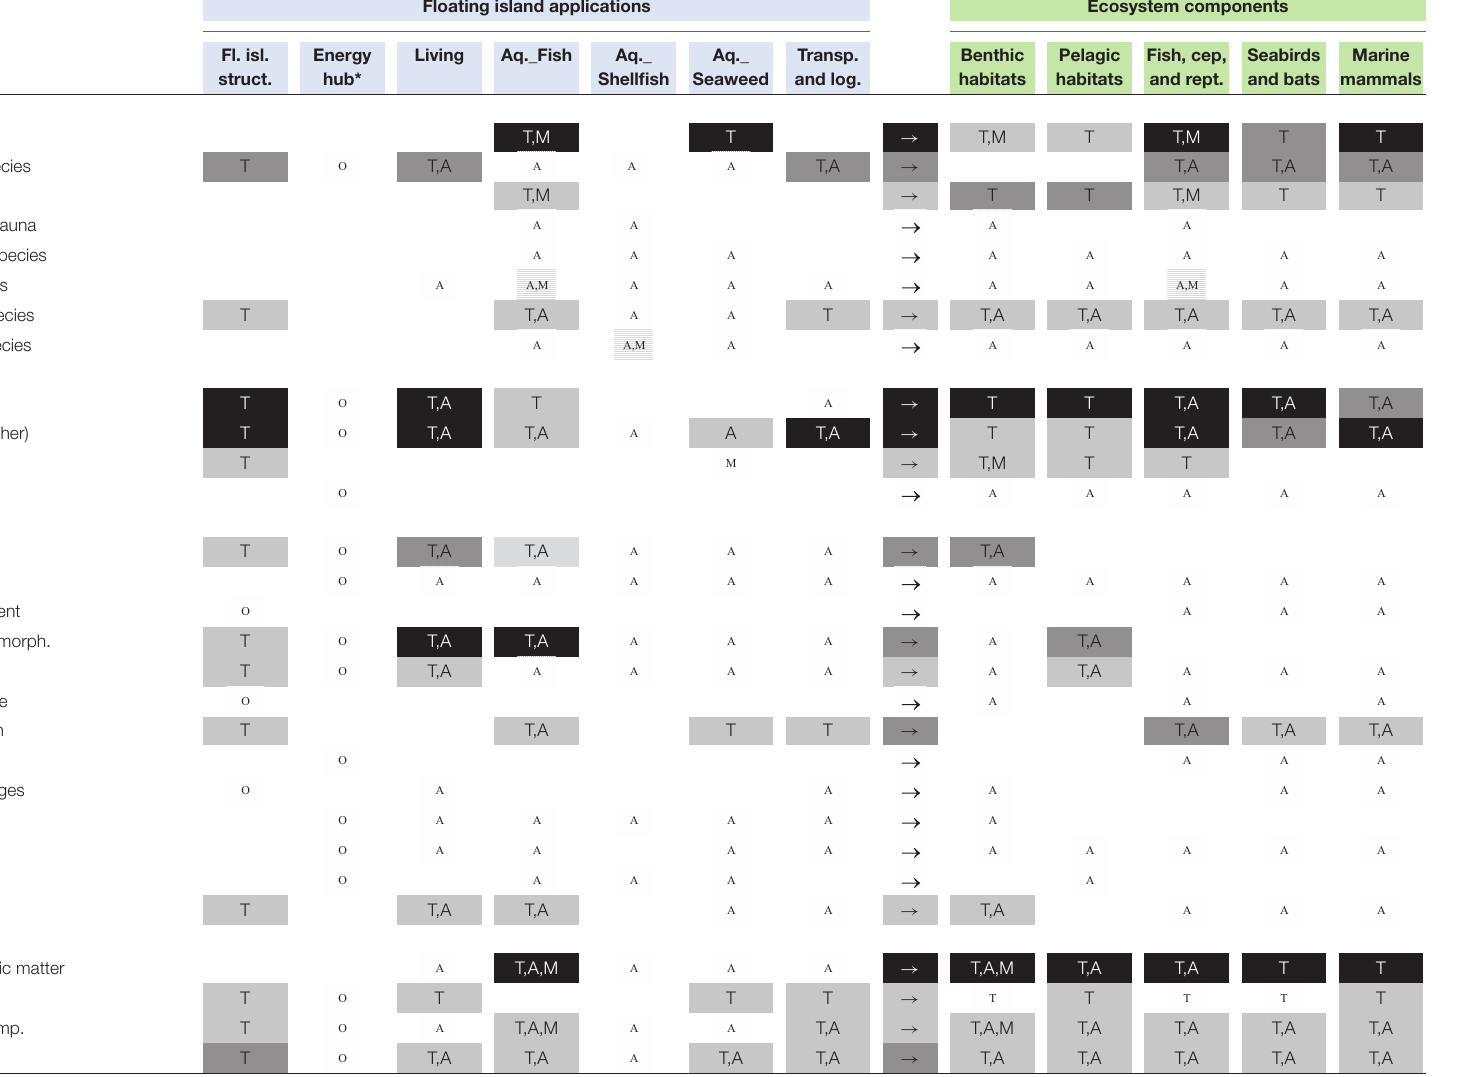
TABLE 4 | Potential impacts of the various applications that are considered in Space@sea, based on a compilation of results from different projects. Floating island applications Ecosystem